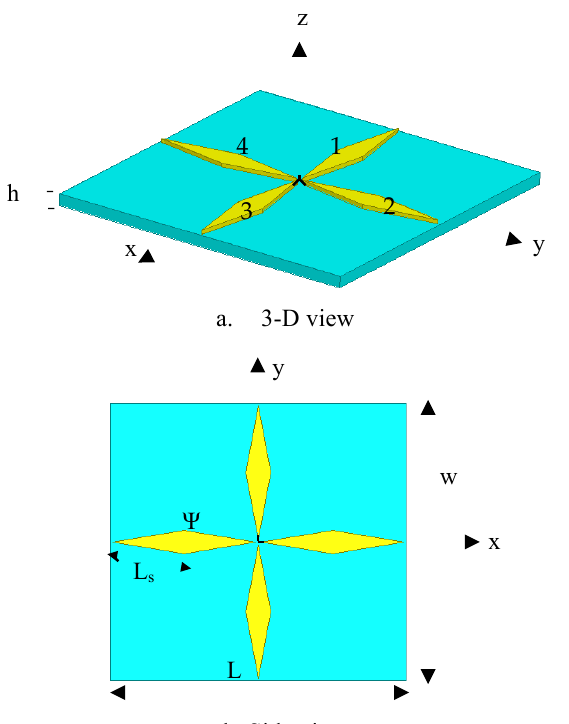
Figure 12. The detailed construction of the rhombic dipole IR - nanoantenna on a dielectric substrate with h=150 nm, w=9 µ m, L=9 µ m, L =2.2 µ m, t=50 nm and gap=10 nm. s